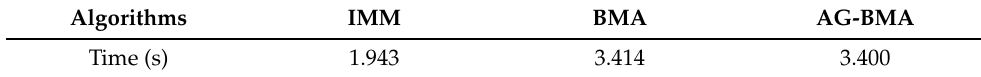
Table 3. Computational time taken by the three algorithms in